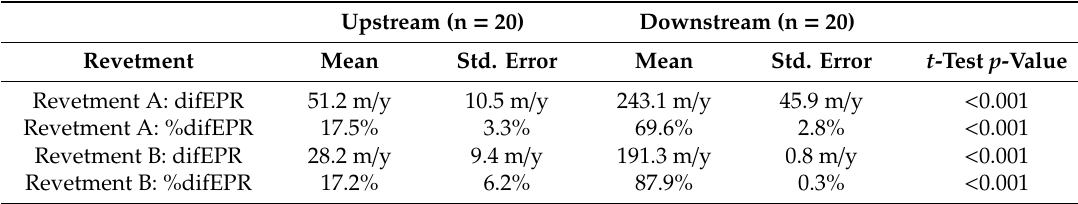
Table 11. End Point Rate change: difEPR and %difEPR difference of means by upstream/downstream